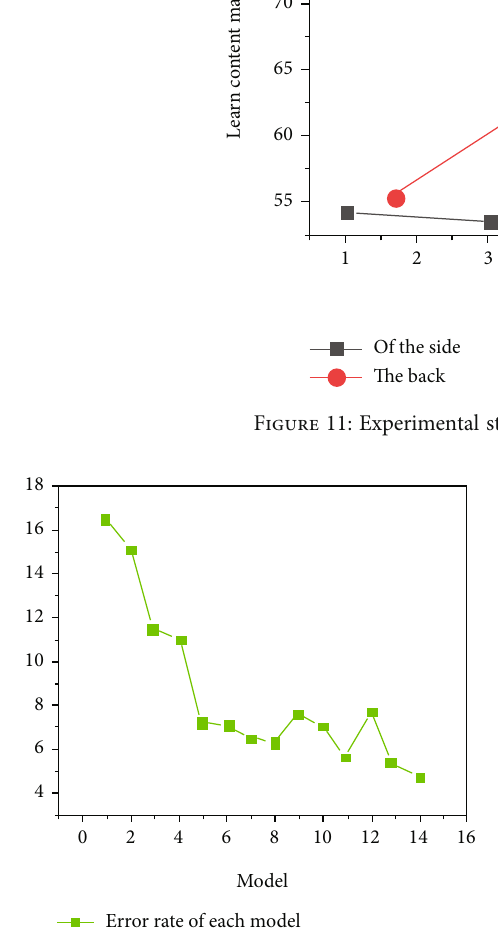
Figure 12: Top-5 error data map (top-5 indicates that the correct value is in the top 5 data with